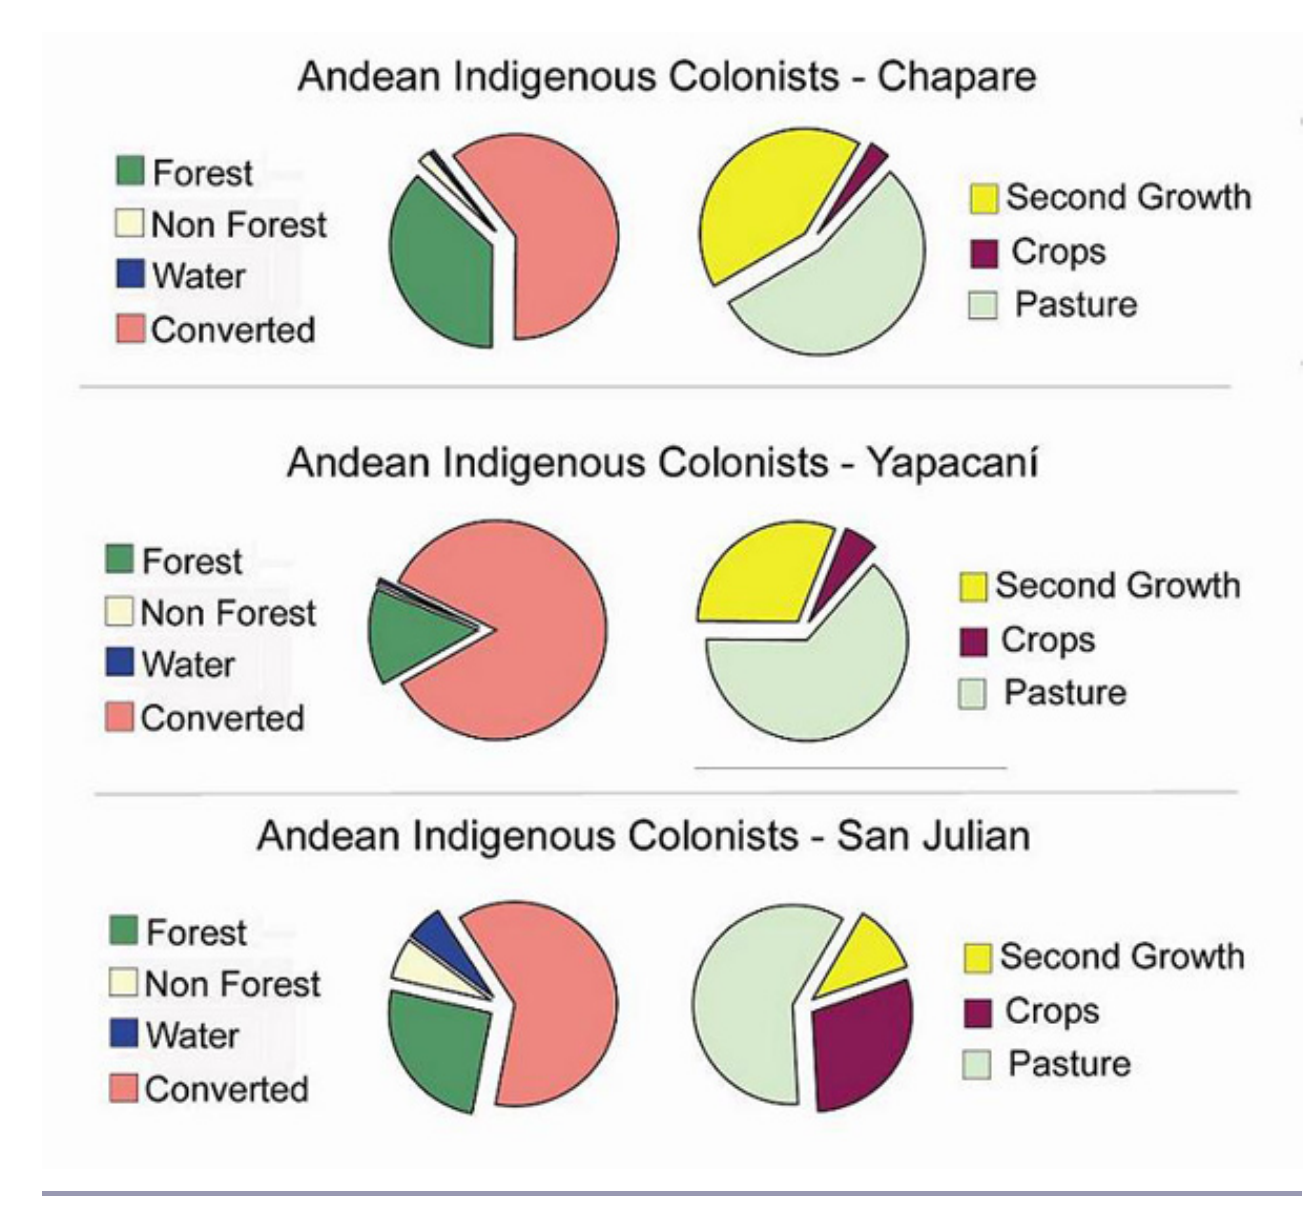
Fig. 4. Land use and land-use intensity for three regions occupied by Andean indigenous